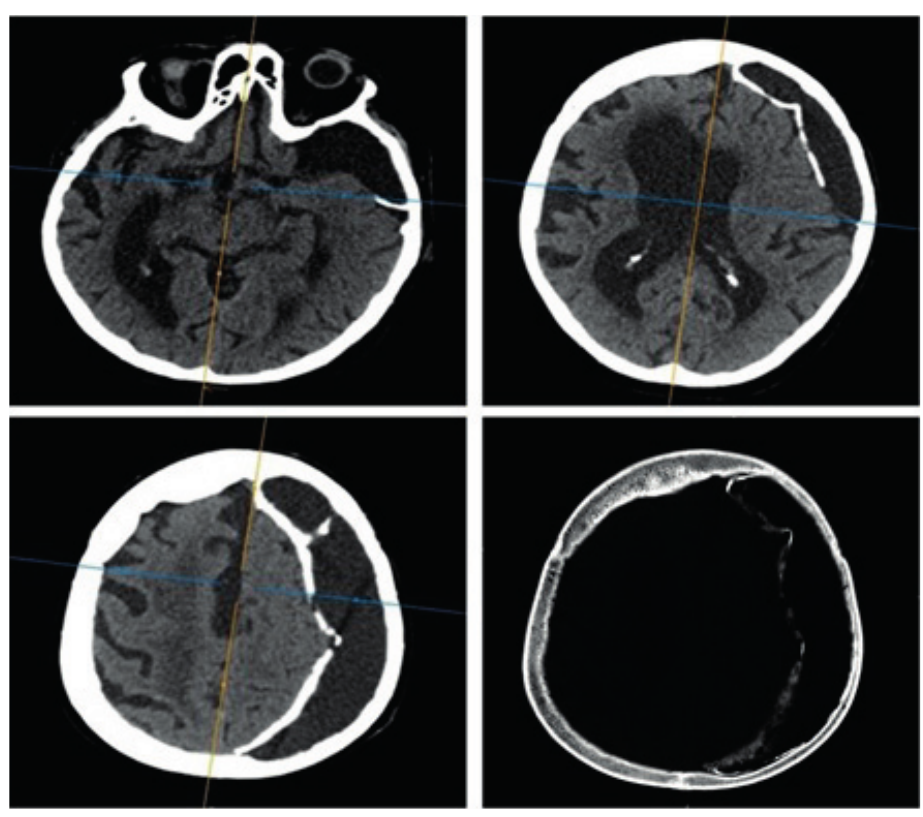
Fig. 1. Preoperative non-contrast brain CT scan (with bony window) showing subdural mass over the left hemisphere with calcified/ossified membranes.